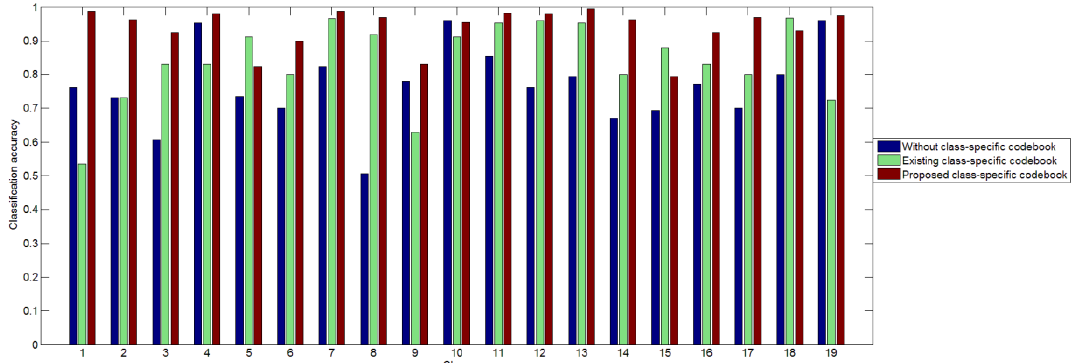
Figure 12. Classification accuracy per class for classifiers using WHU-RS dataset. The rows and columns of the matrix denote the actual and predicted classes, respectively. The class labels are assigned as follows: 1 = airport, 2 = beach, 3 = bridge, 4 = commercial, 5 = desert, 6 = farmland, 7 = football field, 8 = forest, 9 = industrial, 10 = meadow, 11 = mountain, 12 = park, 13 = parking, 14 = pond, 15 = port, 16= railway station, 17 = residential, 18 = river, 19 = viaduct.